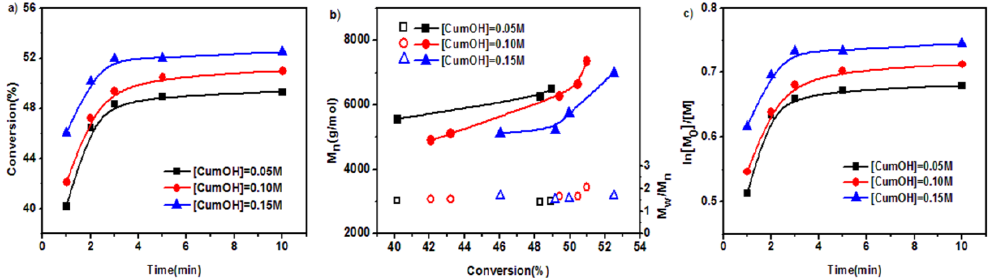
Figure 3. IBVE cationic polymerization initiated by CumOH/B(C 6 F 5 ) 3 /Et 2 O in H 2 O at 20 ◦ C: ( a ) conversion vs time; ( b ) M n and M w / M n vs conversion; ( c ) ln[ M 0 ]/[ M ] vs time. [IBVE] = 1.6 M;